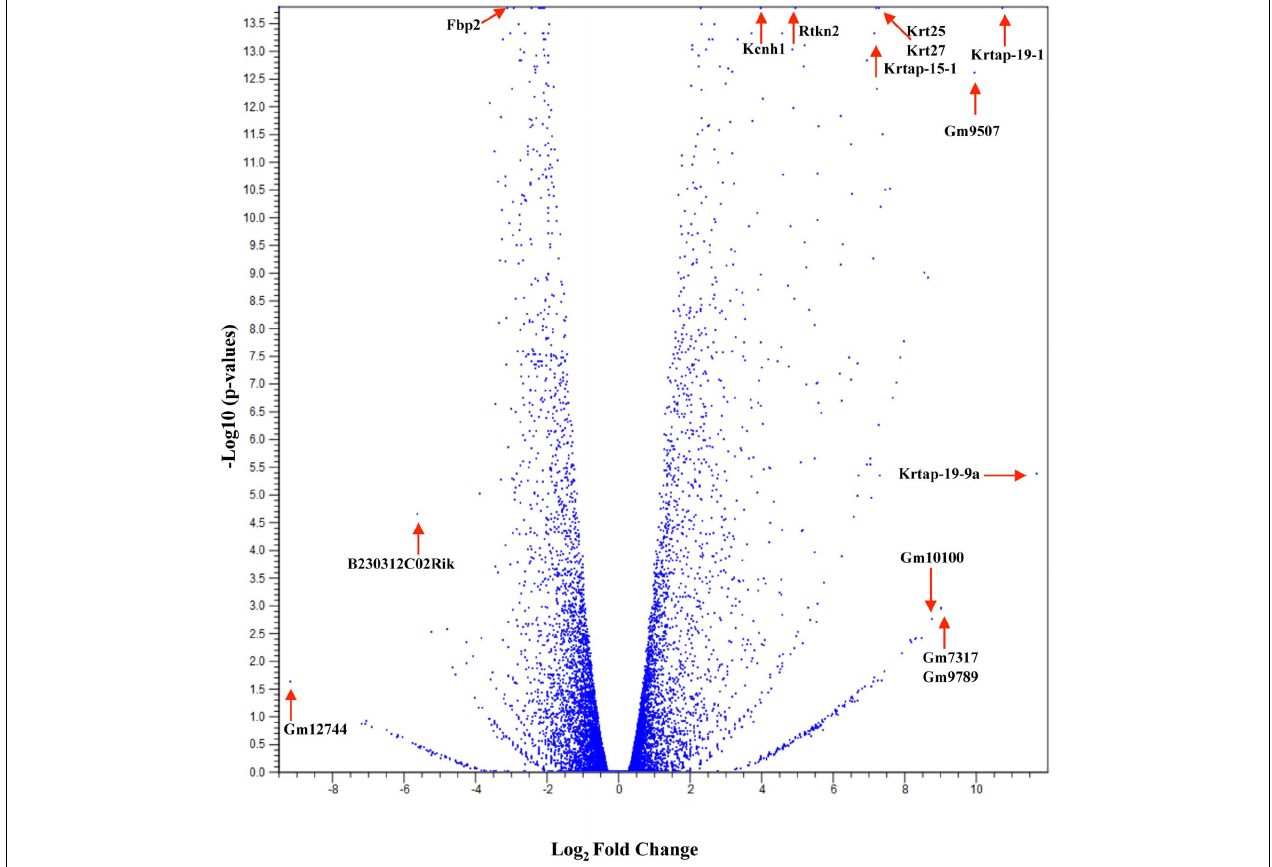
FIGURE 3 | Overall cutaneous gene expression changes in IL-6-deficient versus C57BL/6 control skin. Total RNA was isolated from untreated C57 and IL-6KO (KO) normal skin samples and subjected to transcriptome analysis by MiSeq ( n = 6/experimental group). Volcano plot comparing gene expression levels in terms of log 2 fold change versus significance in both group comparisons. The y -axis corresponds to the mean expression value of log 10 ( p -value), and the x -axis displays the log 2 fold change